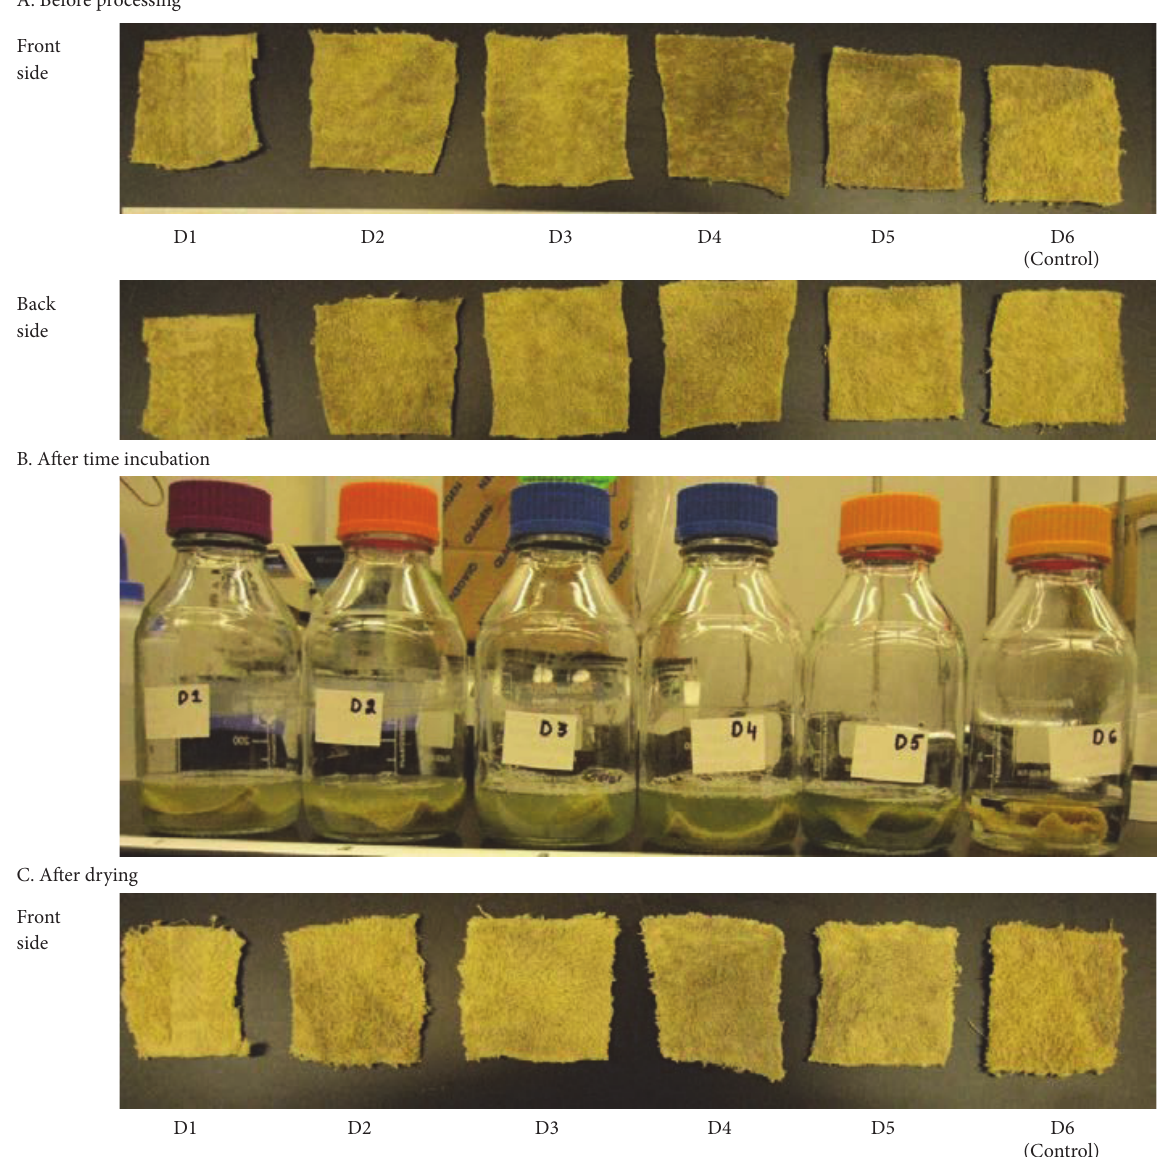
Figure 5: Visual views of cloth samples processed with WBD formulations (commercial detergent T). Note: An alphabetical integer value represents compositions of different detergent formulation as listed in Table